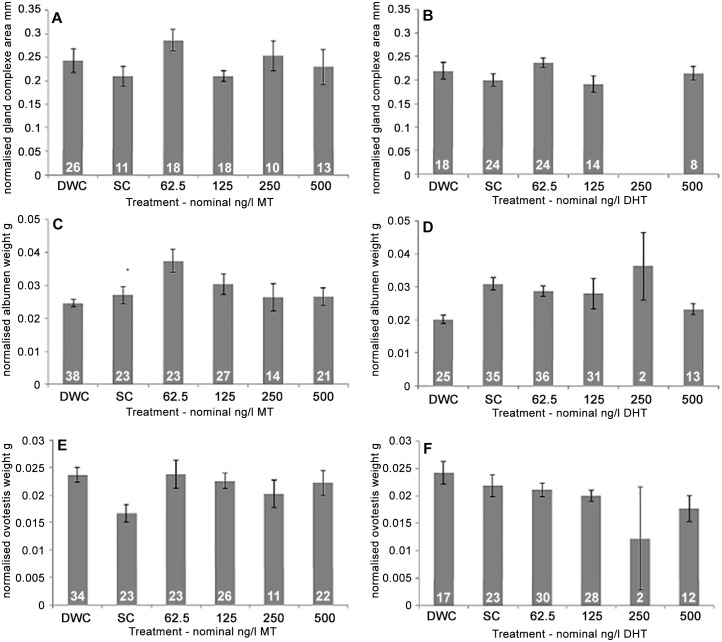
Average normalized size of reproductive tissues from B. glabrata developmentally exposed to methyltestosterone or dihydrotestosterone.Normalized surface area (mm) of glandular complex (A, B), normalized albumen gland weight (g) (C, D) and normalized ovotestis weight (g) (E, F) from B. glabrata developmentally exposed to MT (A, C, E) or DHT (B, D, F) through to sexual maturity (30-day exposure). Error bars represent standard error. White numbers within bar indicate sample size (n). Treatments;—Dilution Water Control (DWC), Solvent Control (SC) and 62.5, 125, 250 and 500 ng/L of either MT (A, C, E) or DHT (B, D, F).